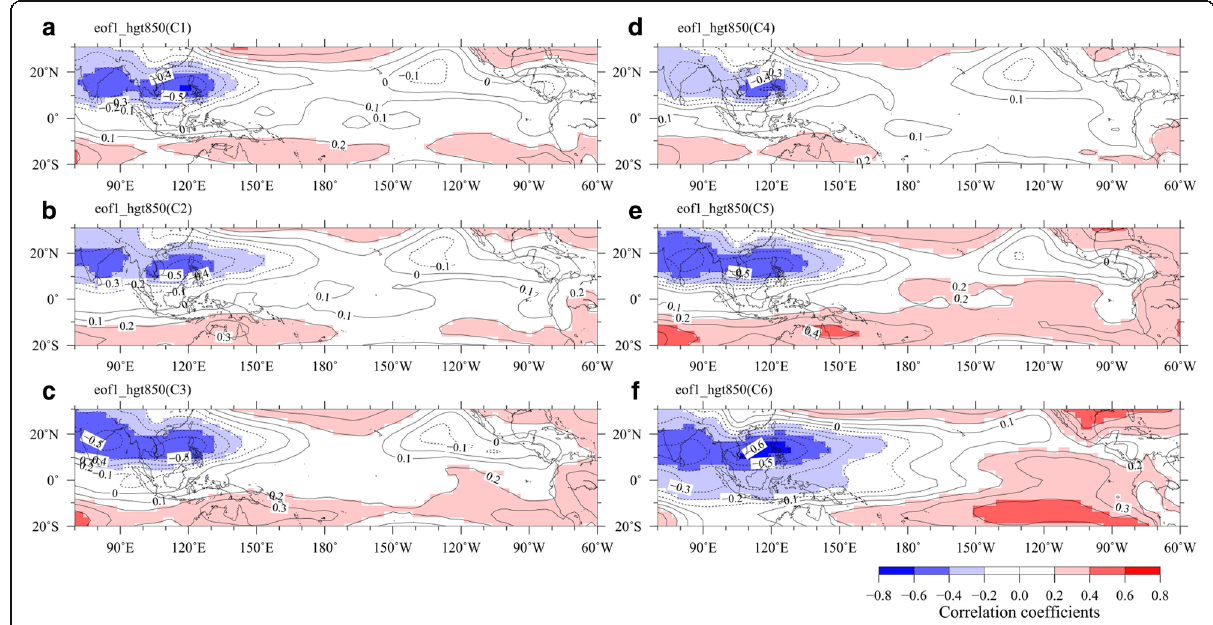
Fig. 10 Correlation maps between the time coefficients of EOF1 and geopotential height at the 850 hPa level during the year classified in a C1, b C2, c C3, d C4, e C5, and f C6. Correlation coefficients above 0.2 or below − 0.2 indicate a significant correlation at the two-sided 99% level according to Student ’ s t